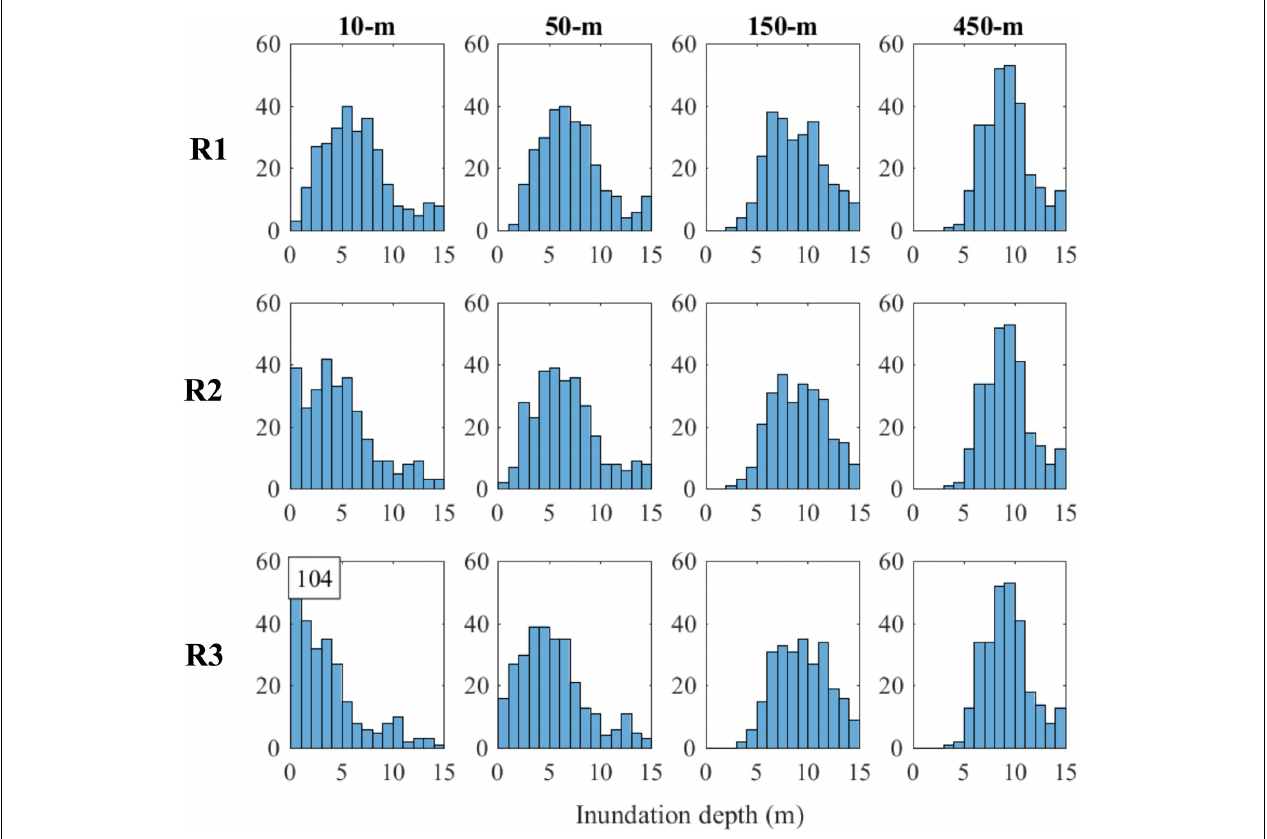
FIGURE 14 | Inundation depth distribution at three locations in Onagawa for the M w 9.0 events by considering different DEM resolutions (The counts exceeding the y axis limit are indicated in a box). The histogram in each subfigure panel is based on 300 stochastic slip models.